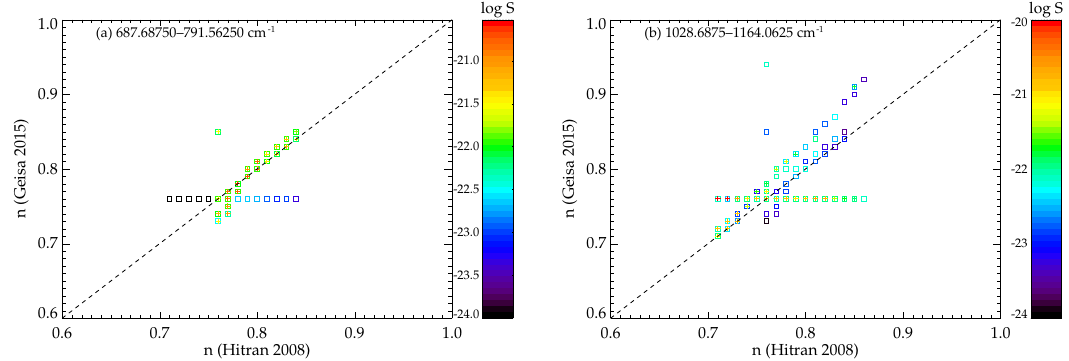
Figure 9. (a) Coefficients n of temperature dependence of the air-broadened half widths of GEISA-2015 versus HITRAN-2008 for the microwindows in MIPAS channel A. (b) Same as on the left but for the microwindows in channel AB. The coefficients are colour-coded by the logarithm of the HITRAN-2008 line intensities. Plotted squares and pluses denote coefficients associated with line strengths lower or larger than 1 × 10 − 22 cm − 1 /(moleculecm − 2 ) at